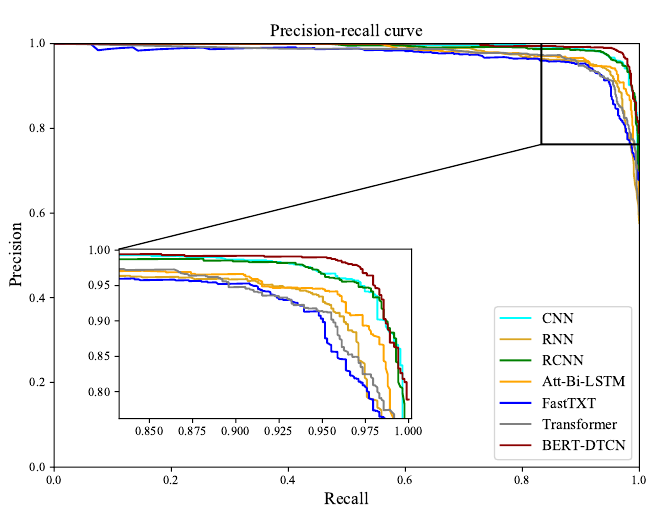
Figure 14. The PR curves for BERT-DTCN and competing